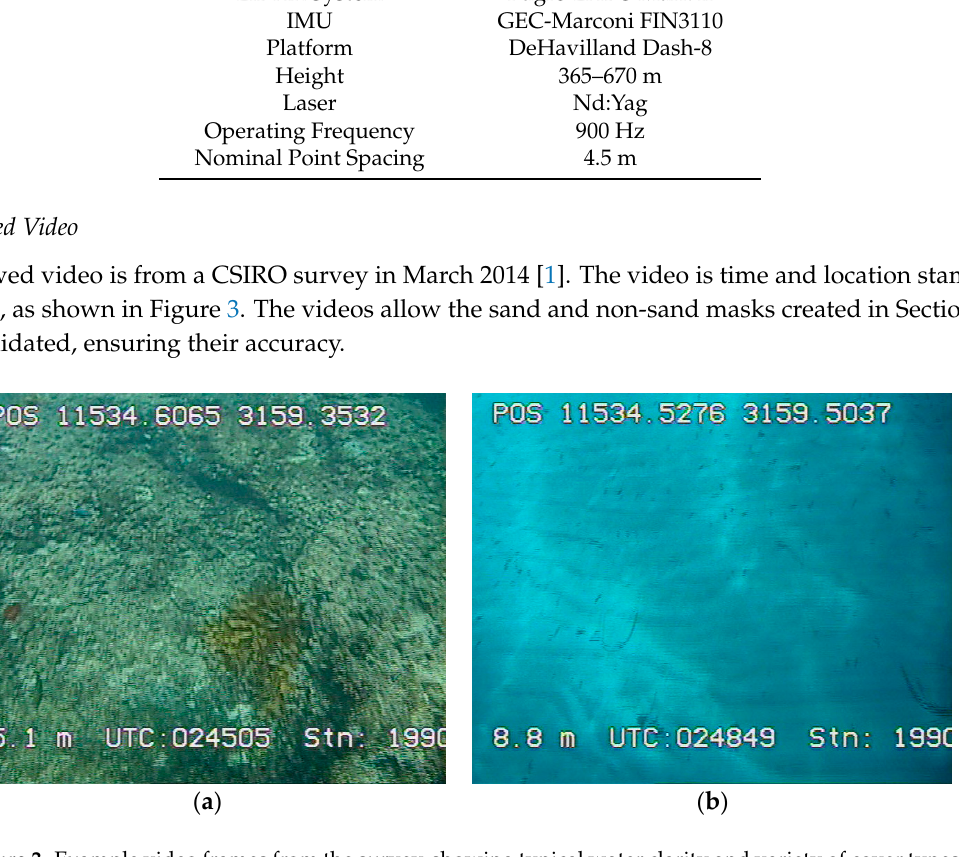
Figure 3. Example video frames from the survey, showing typical water clarity and variety of cover types in the scene. Positions are shown in lat.-long. × 1000 at top of frames. ( a ) Reef image. ( b ) Sand image.